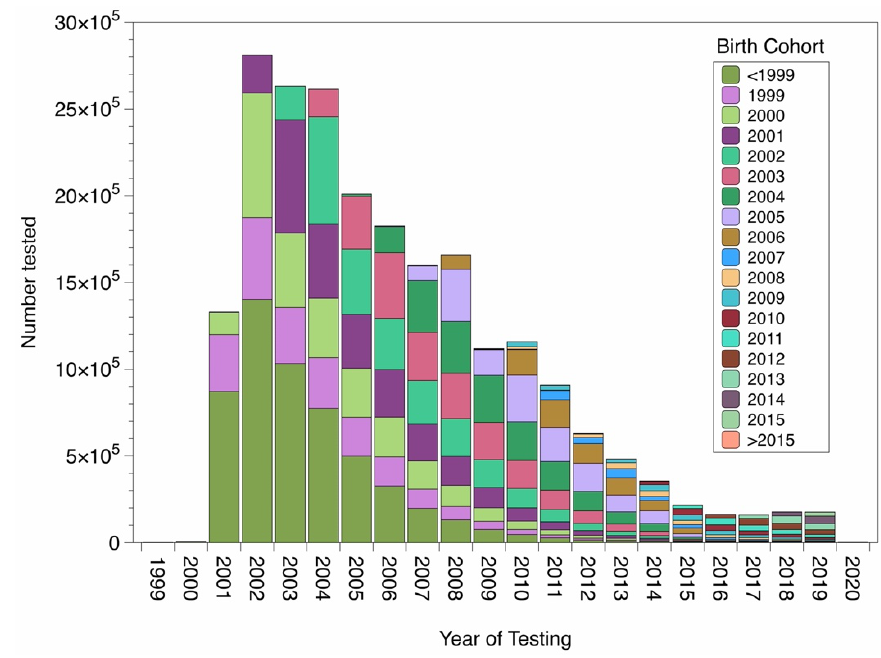
Figure 1. Slaughter animals tested for BSE stratified by birth cohort .